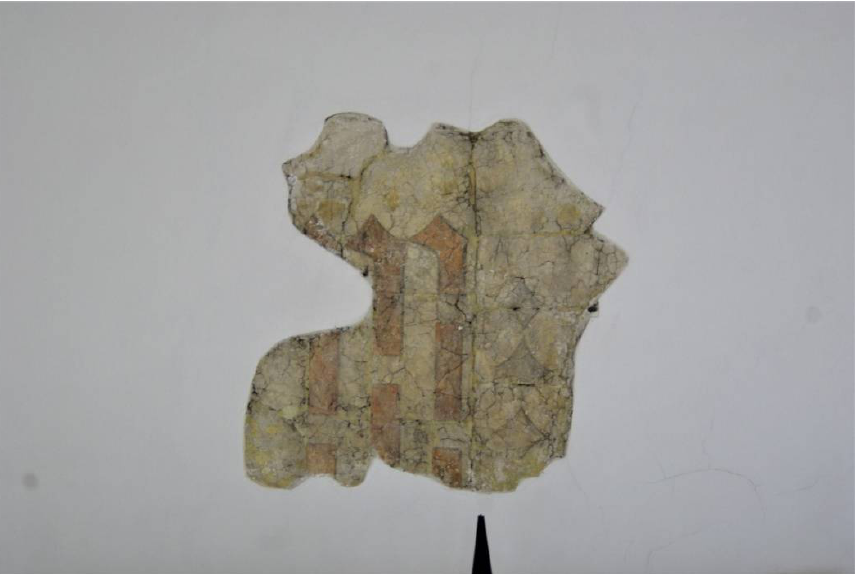
Figure 11. Kraków, Wawel castle, Casimir Hall. Fragment of paintings. Between 1384–1399. Photo Figure 11. Krak ó w, Wawel castle, Casimir Hall. Fragment of paintings. Between 1384–1399. Photo by by Tomasz Ratajczak, the author’s own work. Tomasz Ratajczak, the author’s own